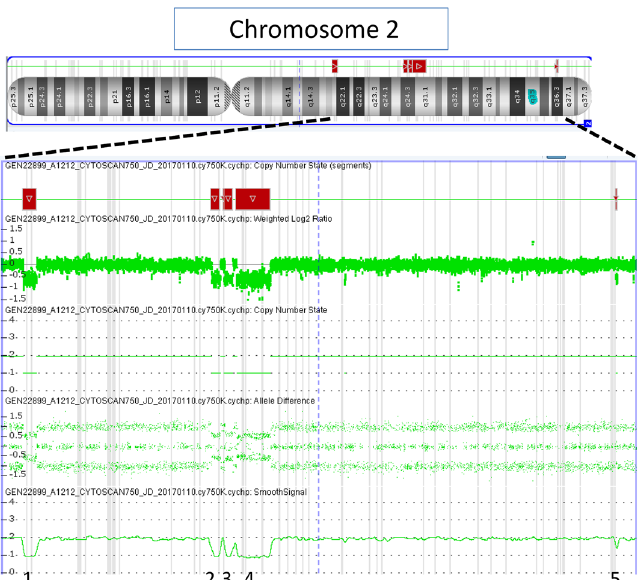
Figure 3. Result of the Affymetrix CytoScan 750 SNP array in patient 15: In the upper part, ideogram of chromosome 2 with the deleted regions marked with black boxes. In the lower part, detailed view the long arm of chromosome 2 where the different deletions are